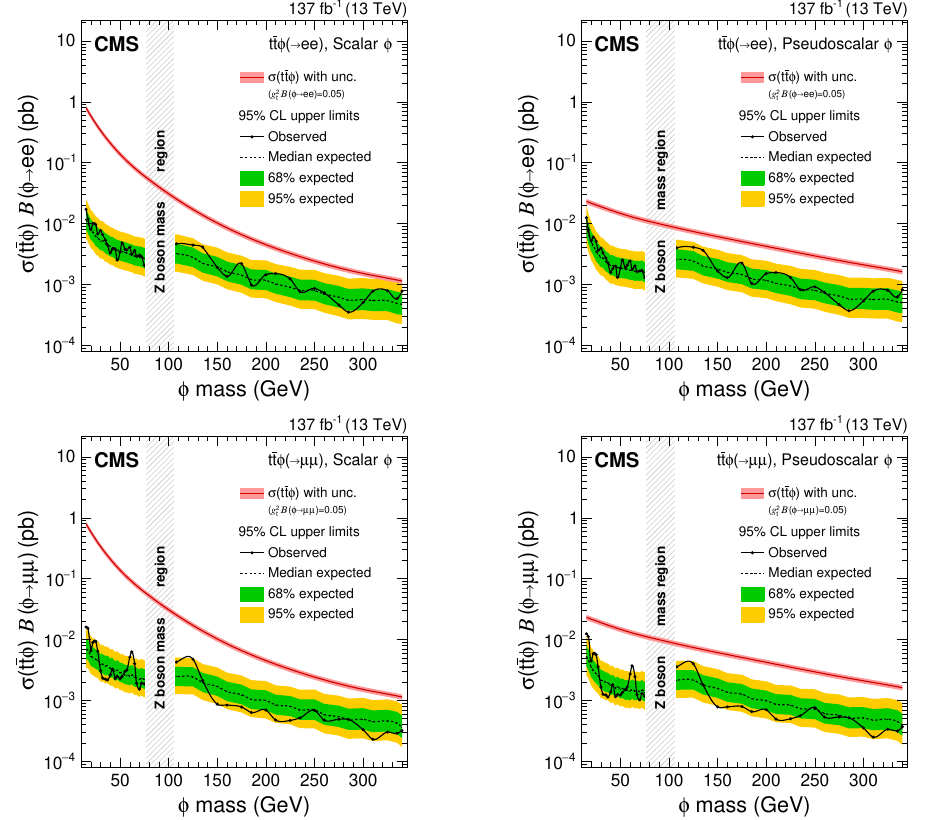
Figure 12 . The 95% con(cid:12)dence level expected and observed upper limits on the product of the signal production cross section and branching fraction of a scalar (cid:30) boson in the dielectron (upper left) and dimuon (lower left) channels, and of a pseudoscalar (cid:30) boson in the dielectron (upper right) and dimuon (lower right) channels, where (cid:30) is produced in association with a top quark pair. The inner (green) and the outer (yellow) bands indicate the regions containing 68 and 95%, respectively, of the distribution of limits expected under the background-only hypothesis. The vertical hatched gray band indicates the mass region corresponding to the Z boson veto. Also shown are